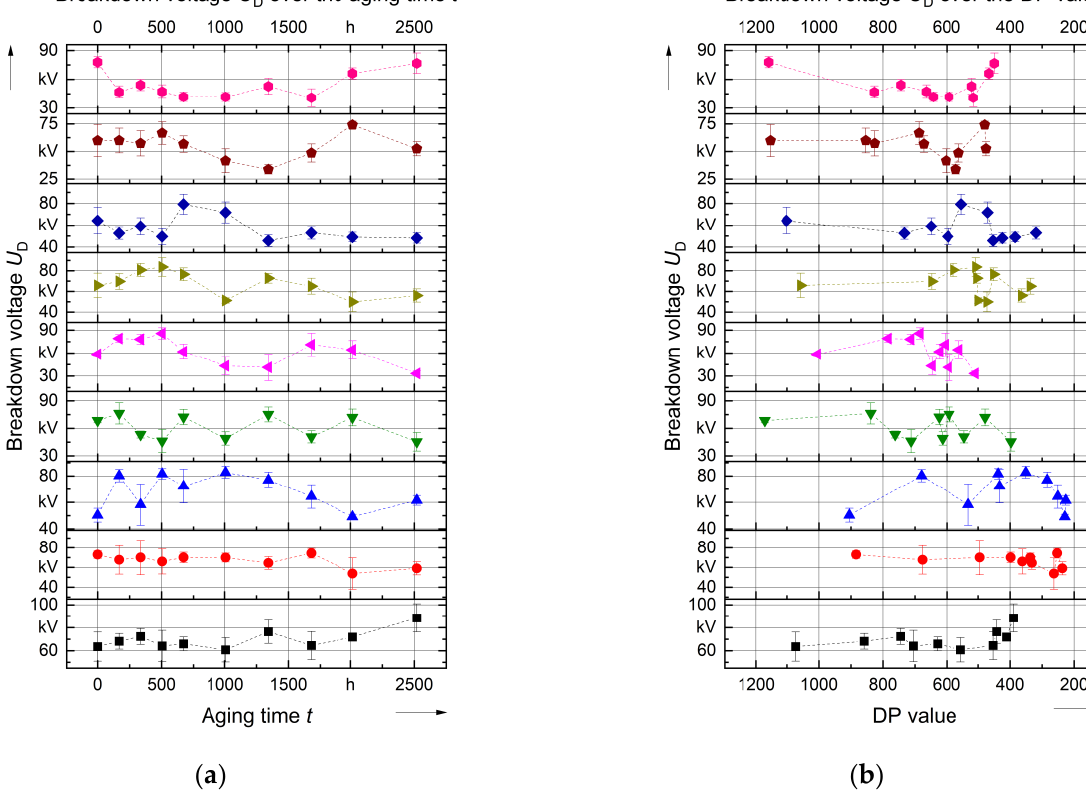
Figure 12. Change of breakdown voltage U D at room temperature for different sealing systems and fluids: ( a ) Change over the aging time; ( b ) Change over the DP value; the legends refer to Figure 6a.